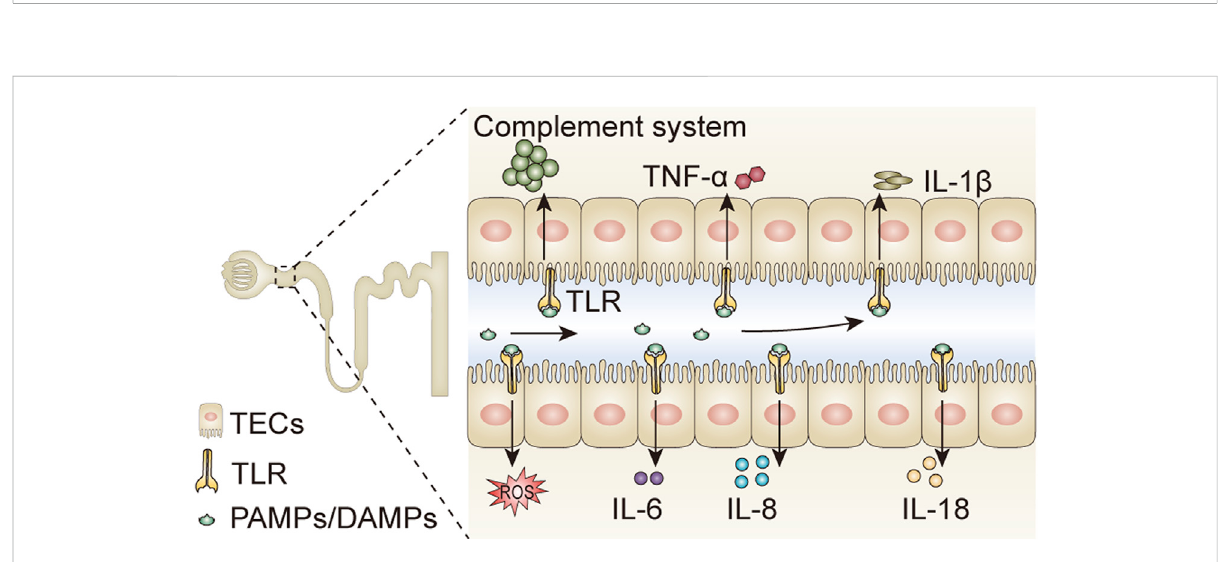
FIGURE 2 Pathogens activate in fl ammatory responses in tubular epithelial cells. PAMPs and DAMPs are compounds existing in various pathogens, which canbe fi lteredthroughtheglomerular fi ltrationbarrier,andbindtoTLRsexpressedontubularepithelialcells.ThebindingofPAMPs/DAMPsandTLRs promotes the release of pro-in fl ammatory cytokines including IL-1 β , IL-6, IL-8, IL-18, TNF- α , and ROS, and simultaneously activates the complement system. PAMPs, pathogen-associated molecular patterns; DAMPs, damage-associated molecular patterns; IL, interleukin; TNF- α , tumor necrosis factor- α ; ROS, reactive oxygen species; TLR, Toll-like receptor; TECs, tubular epithelial